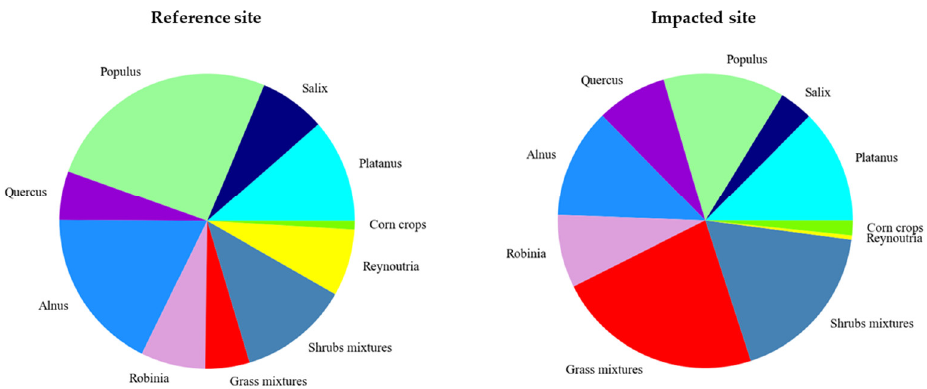
Figure 16. Relative genera abundance as determined by RLR-ℓ1 hyperspectral classification in Materials and Methods Section.